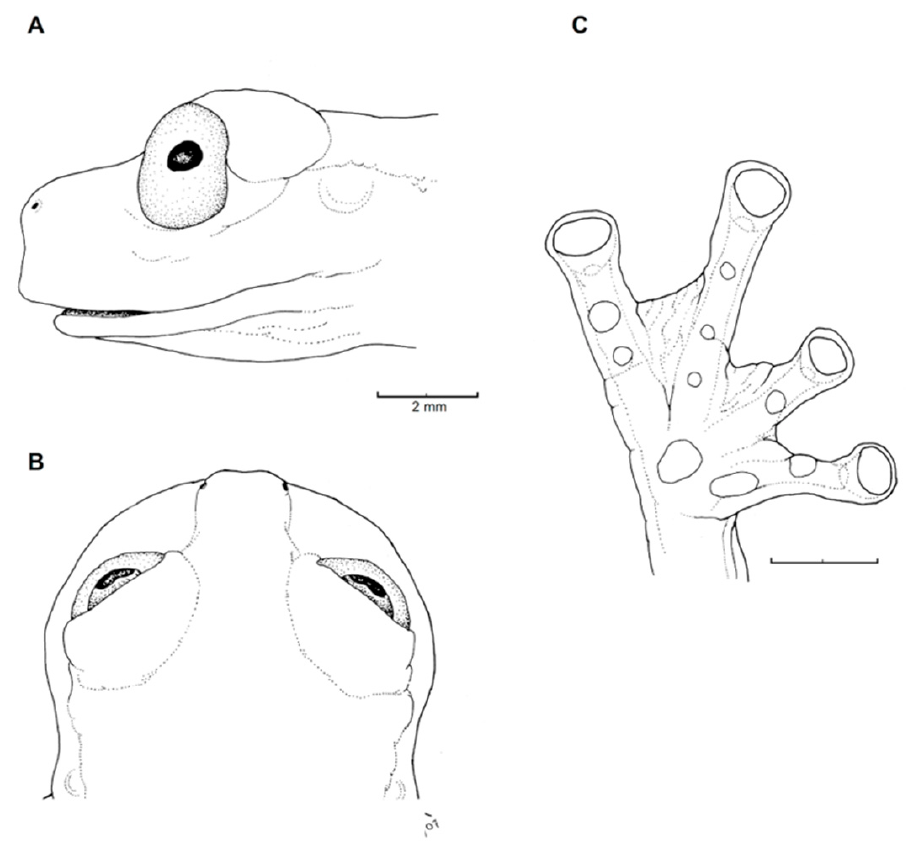
Figure 118. Hyalinobatrachium pellucidum , holotype, KU 143298. ( A ) Head in lateral view. ( B ) Head in dorsal view. ( C ) Hand in ventral view. Illustrations by Juan M. Guayasamin. Color in life (Figure 117): Dorsum pale green with diffuse yellow spots; venter and hidden surfaces of limbs lacking pigment; fingers and toes yellow; parietal peritoneum clear; red heart visible; bones white; iris pale silvery bronze [22].